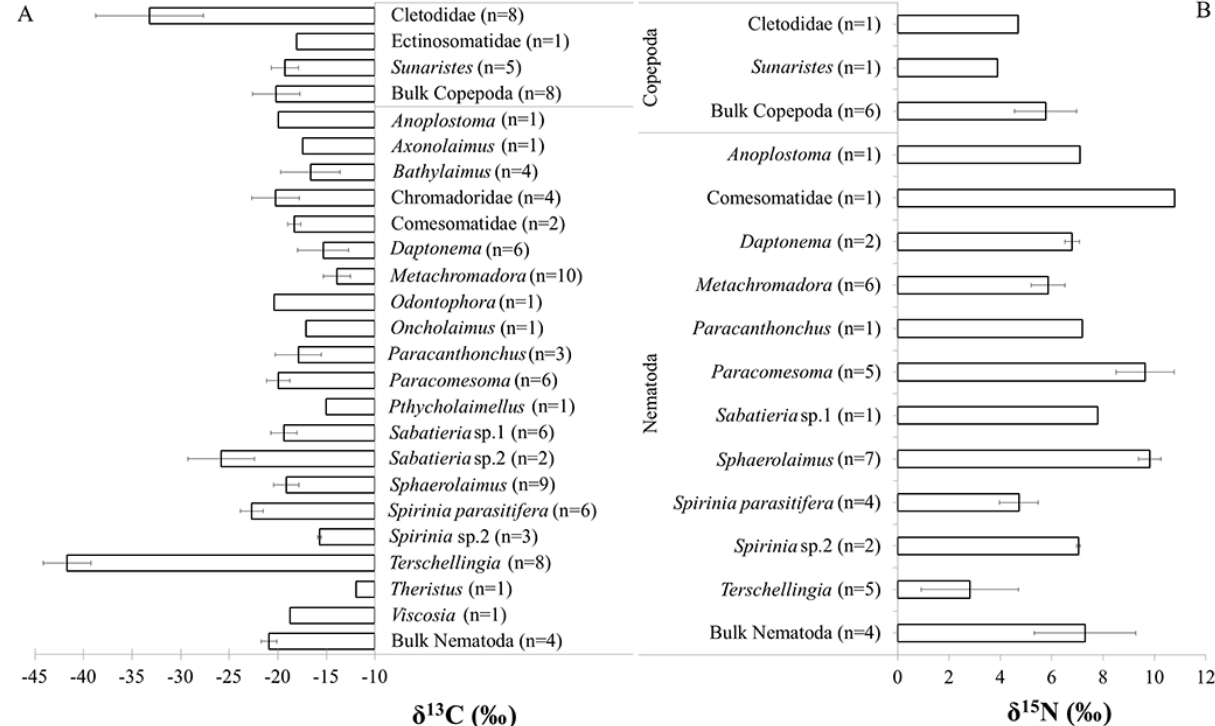
Figure 2. Stable carbon (A) and nitrogen (B) isotope signatures of meiobenthos from the upper 2cm. Data are mean values ( ± SD) of all replicate samples per taxon, from both vegetated and bare stations ( n = number of replicate